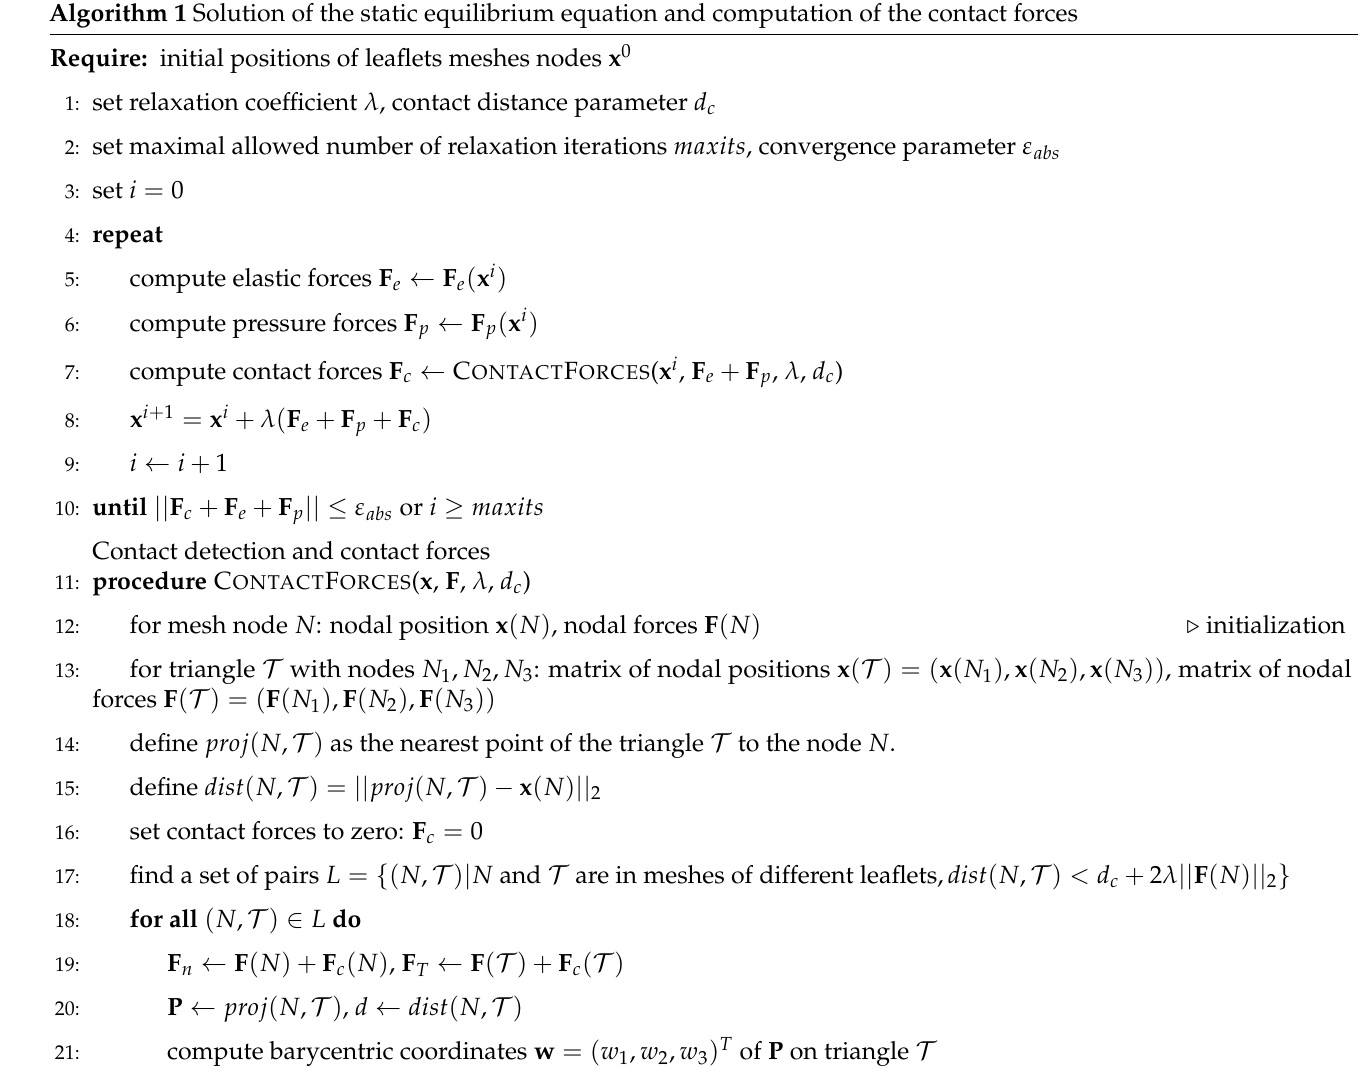
Algorithm 1 Solution of the static equilibrium equation and computation of the contact